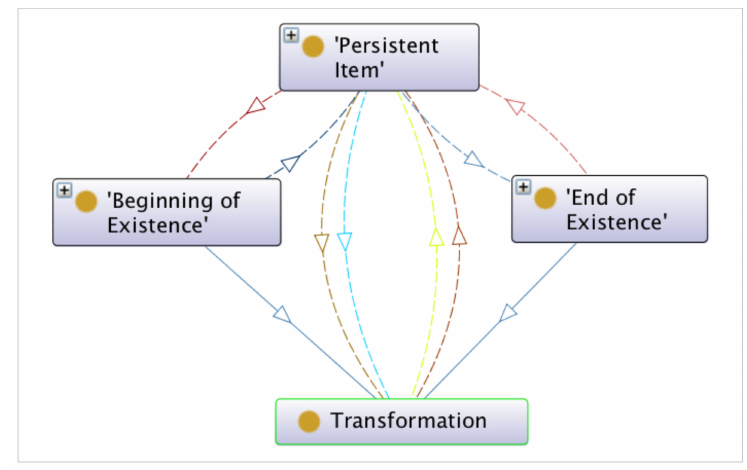
Figure 3. Concept transformation with relationships and